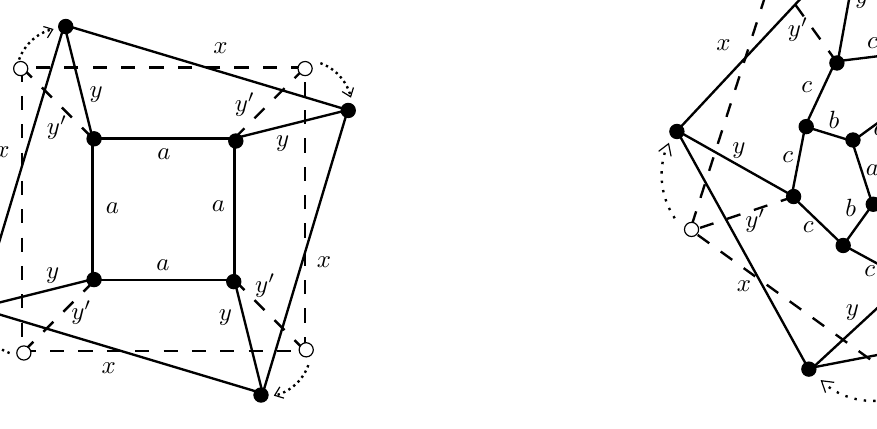
Figure 12: Integral cube graph. Figure 13: Integral dodecahedron